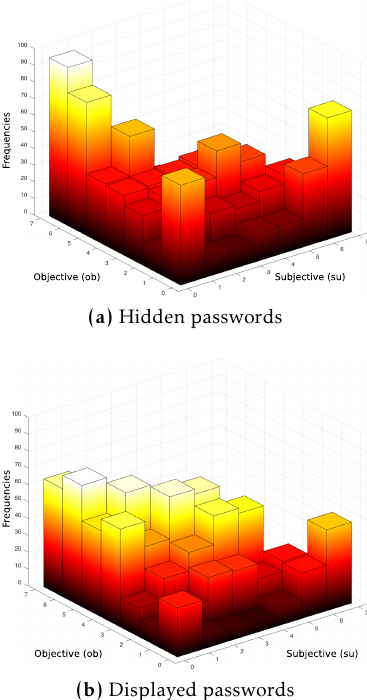
Figure 3. 2-D histograms of participant’s collective behaviors for choosing “su” and